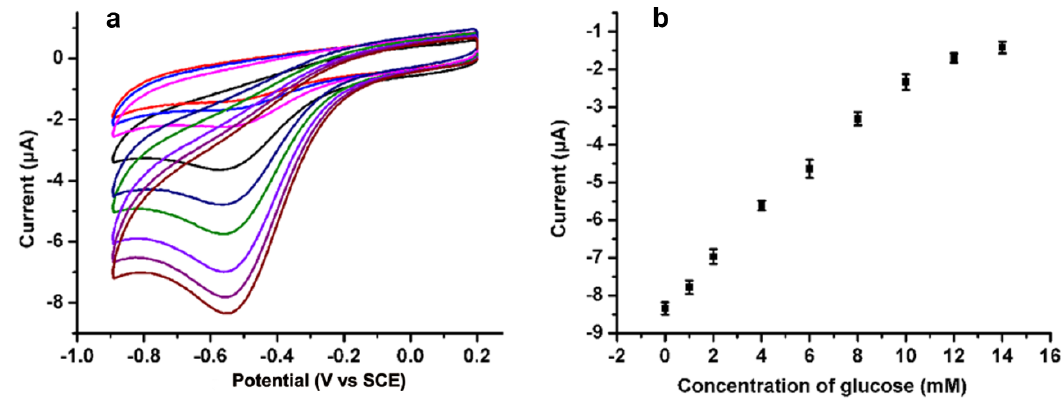
Figure 4. ( a ) Cyclic voltammograms N-doped CDs modified electrode in air-saturated PBS containing 10% of serum sample at a scan rate of 100 mV·s −1 with the addition of different concentrations of glucose; ( b ) Electrochemical response curve for different concentration of glucose.